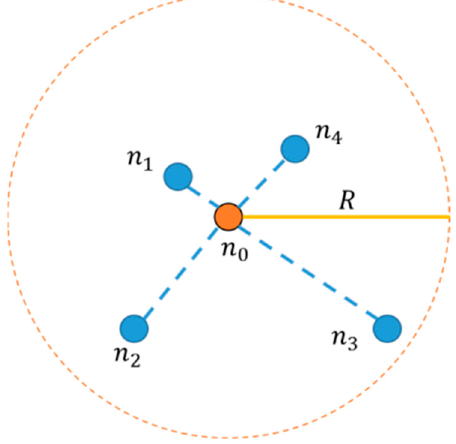
Figure 1. Schematic diagram of the error of hop value.